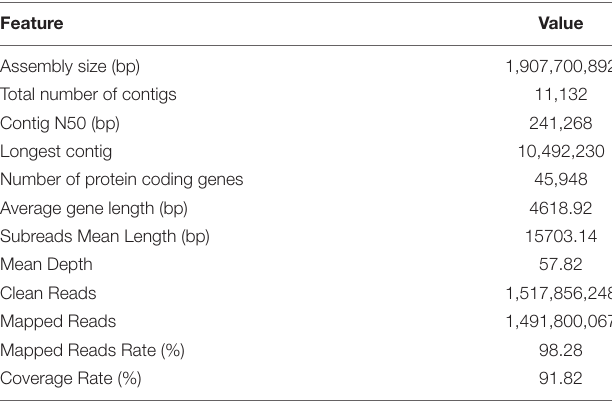
TABLE 1 | Summary of the P. notoginseng genome